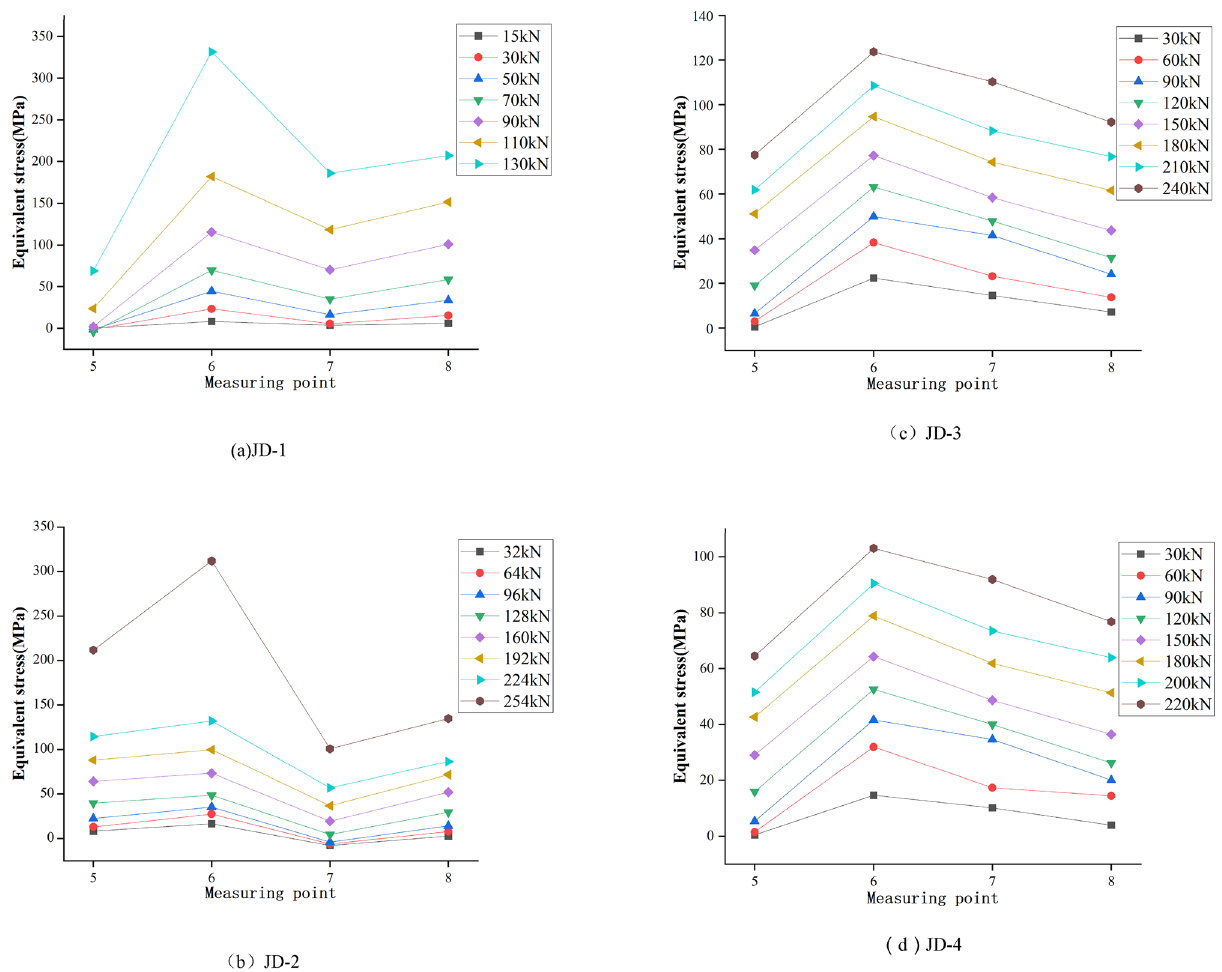
Figure 11. Equivalent stress curve of pressure plate of the ball table at tension